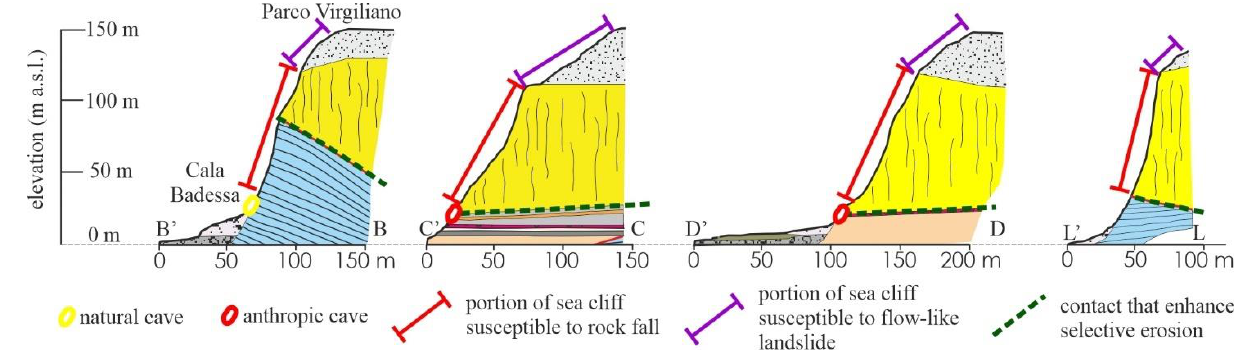
Figure 8. Main predisposing factors controlling cliff stability along the Posillipo promontory. Geological cross-sections are modified from Figure 5. Vertical lines in the NYT indicate sub-vertical fractures affecting this unit.